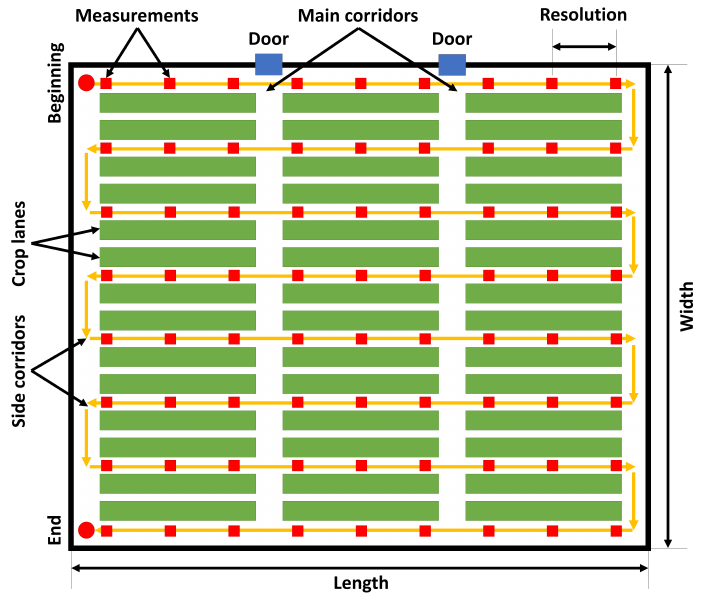
Figure 7. Coverage path planning for the robot team in the